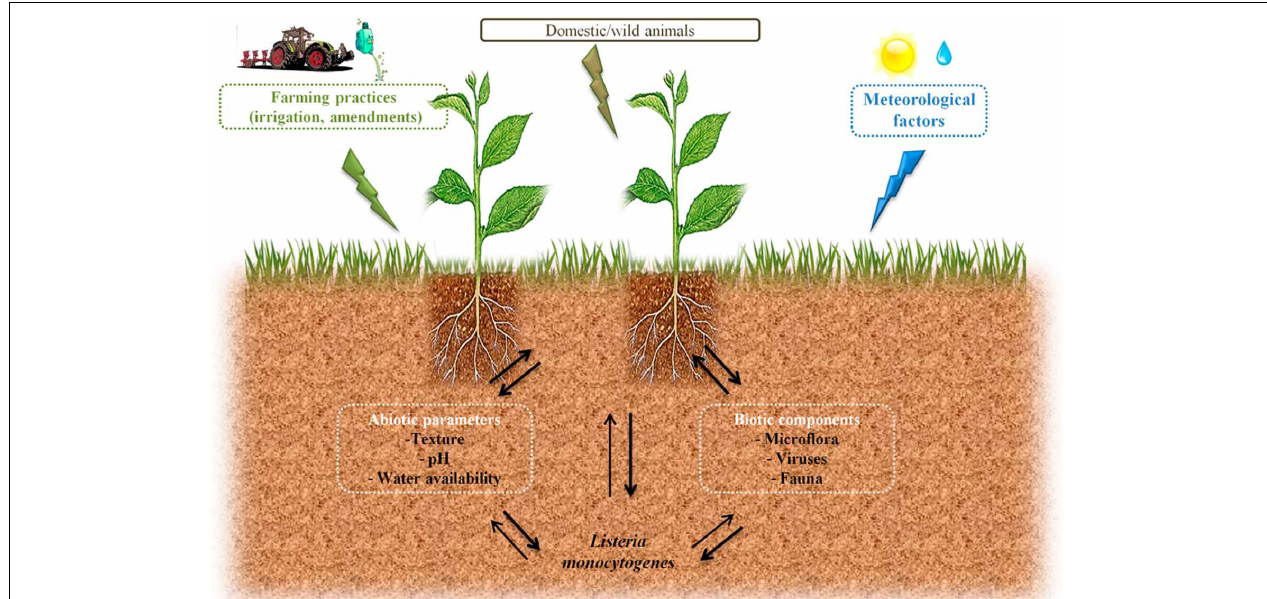
FIGURE 1 | Possible routes of transfer and circulation of L. monocytogenes in the farm environment and factors which can affect its survival in soil.